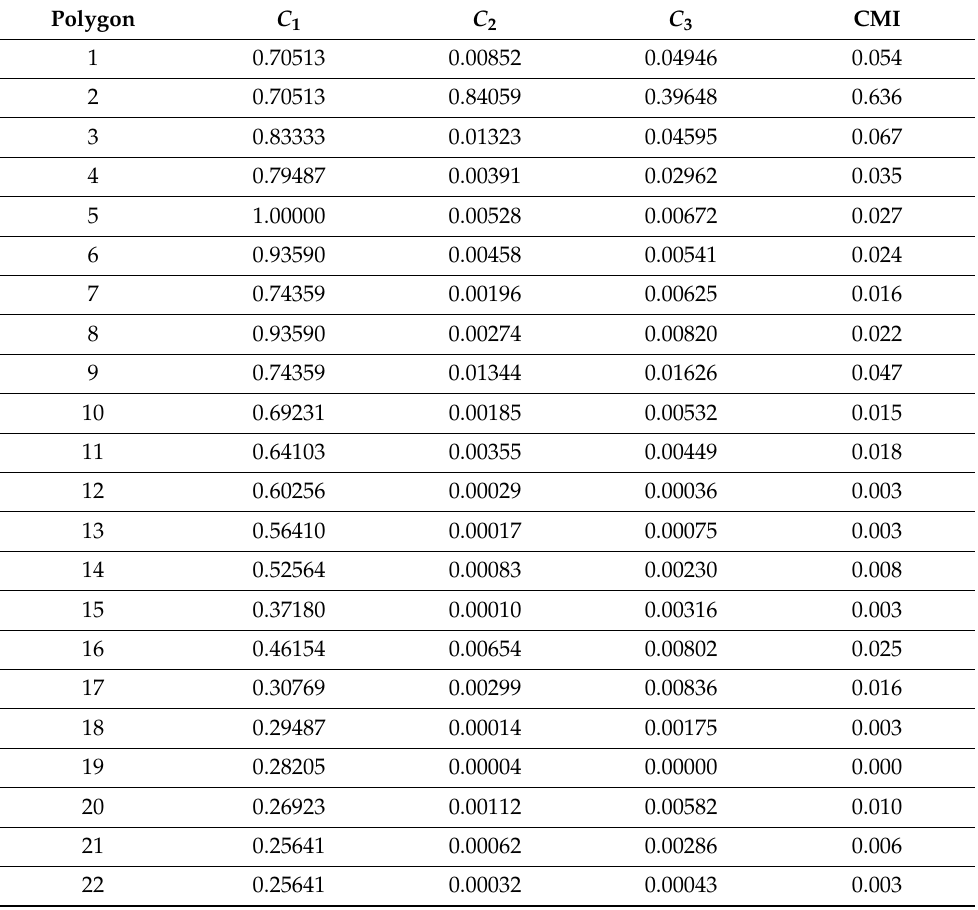
Table A3. Evaluation of components of (Equation (1)) that required determination for each of the 57 actuation polygons by defining the value of CMI for n 1 × 0.3; n 2 × 0.4; y, n 3 × 0.3, in the case of